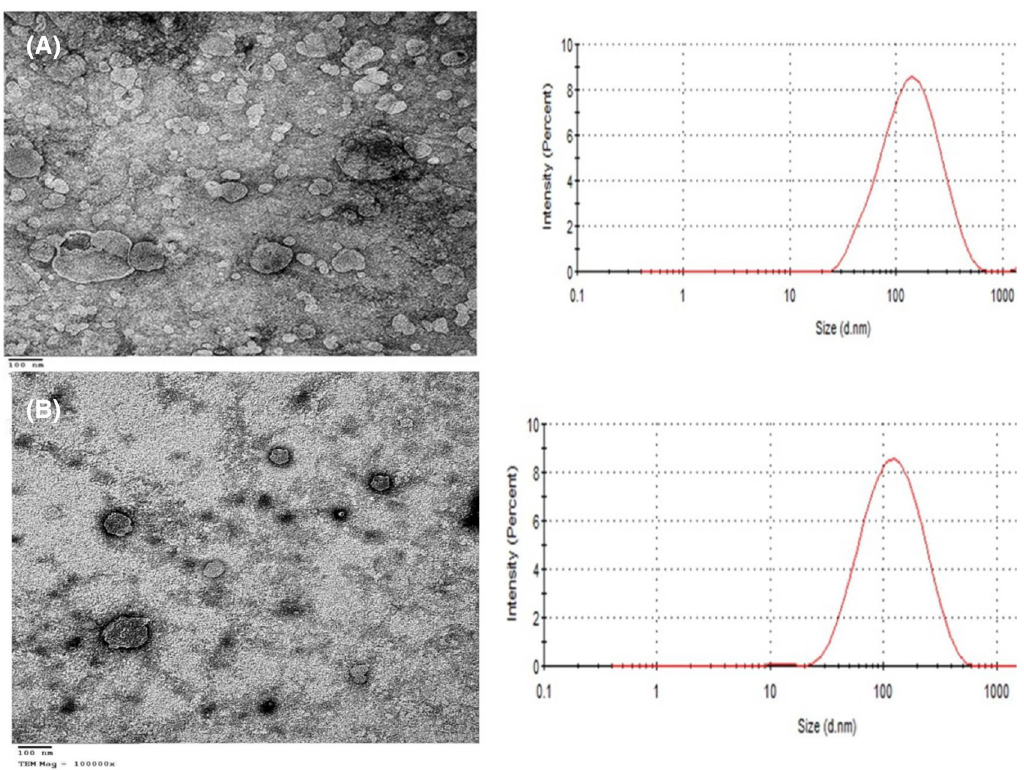
Figure 2. Negative stain electron micrographs (magnification 100000X, scale bar = 100 nm) and particle size distribution curves of ( A ) nobiletin composite PEVs (F13), ( B ) nobiletin composite transfersomes